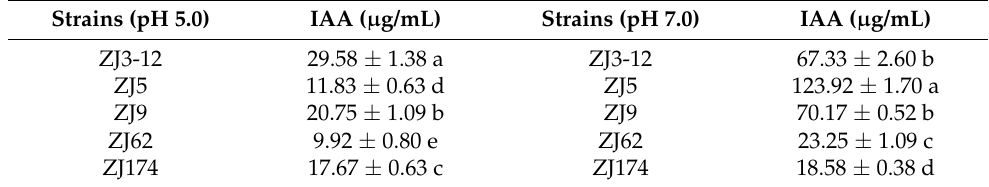
Table 2. Production of IAA by five strains on nutrient broth of different pH with 0.1% tryptophan. Strains (pH